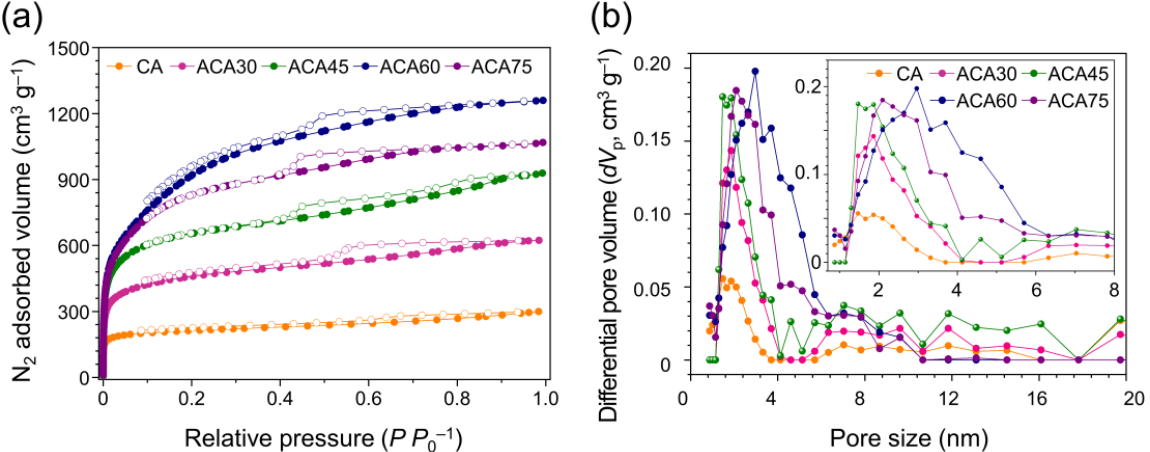
Figure 3. ( a ) N 2 adsorption – desorption isotherms at 77 K (filled circles: adsorption and open circles: desorption) and ( b ) pore size distributions of prepared samples (inset: magnification between pore size of 0.7 and 8 nm).